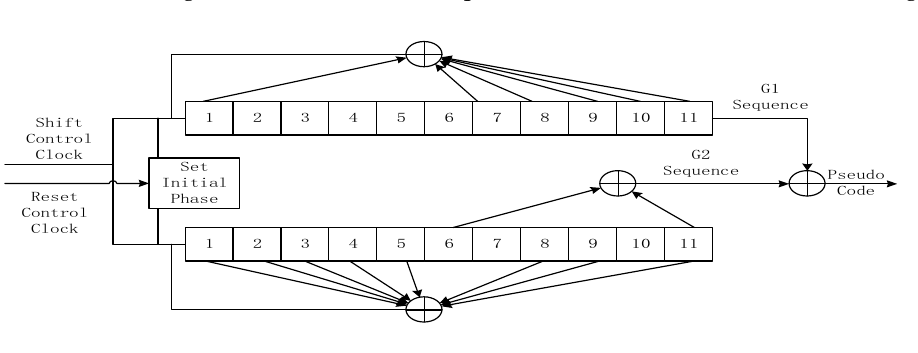
Figure 6. Sketch of BeiDou pseudo code generation.